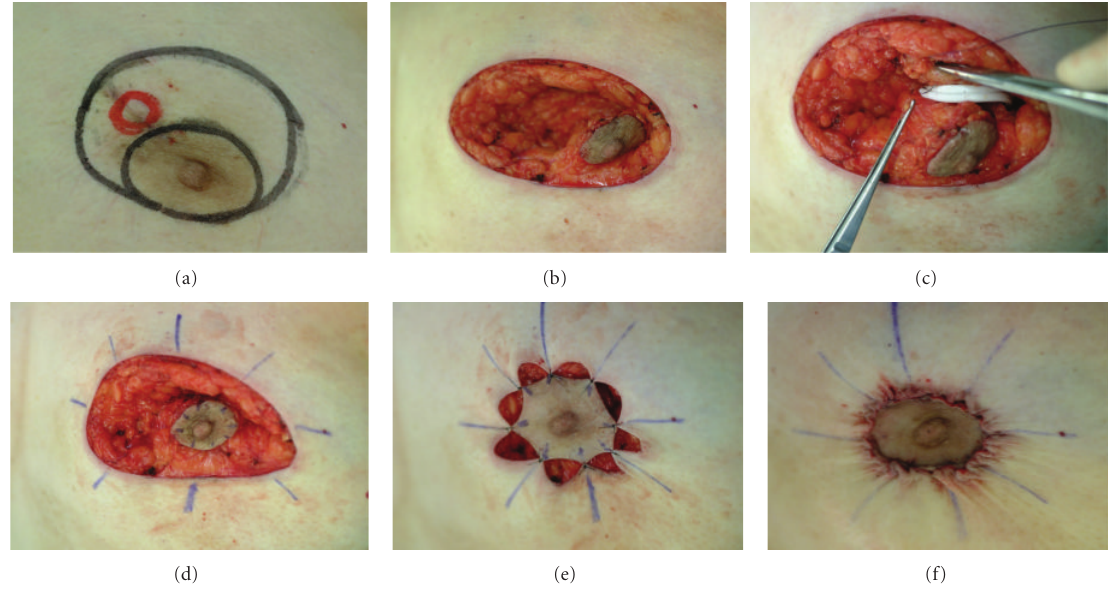
Figure 2: Preoperative design of the periareolar technique showing the tumor. (a) A crescent of skin was removed together with a partial gland. A residual cancer lesion was suspected (red circle). (b) A cylinder of gland tissue was removed together with the pectoralis major muscle. (c) A suction tube was left on the surface of pectoral major muscle. (d) The superior and inferior pedicles were sutured to reduce the defect. (e) The areola suturing was completed with a single suture 4-0 PDS and a running subcuticular 4-0 Monocryl. (f) After closure.